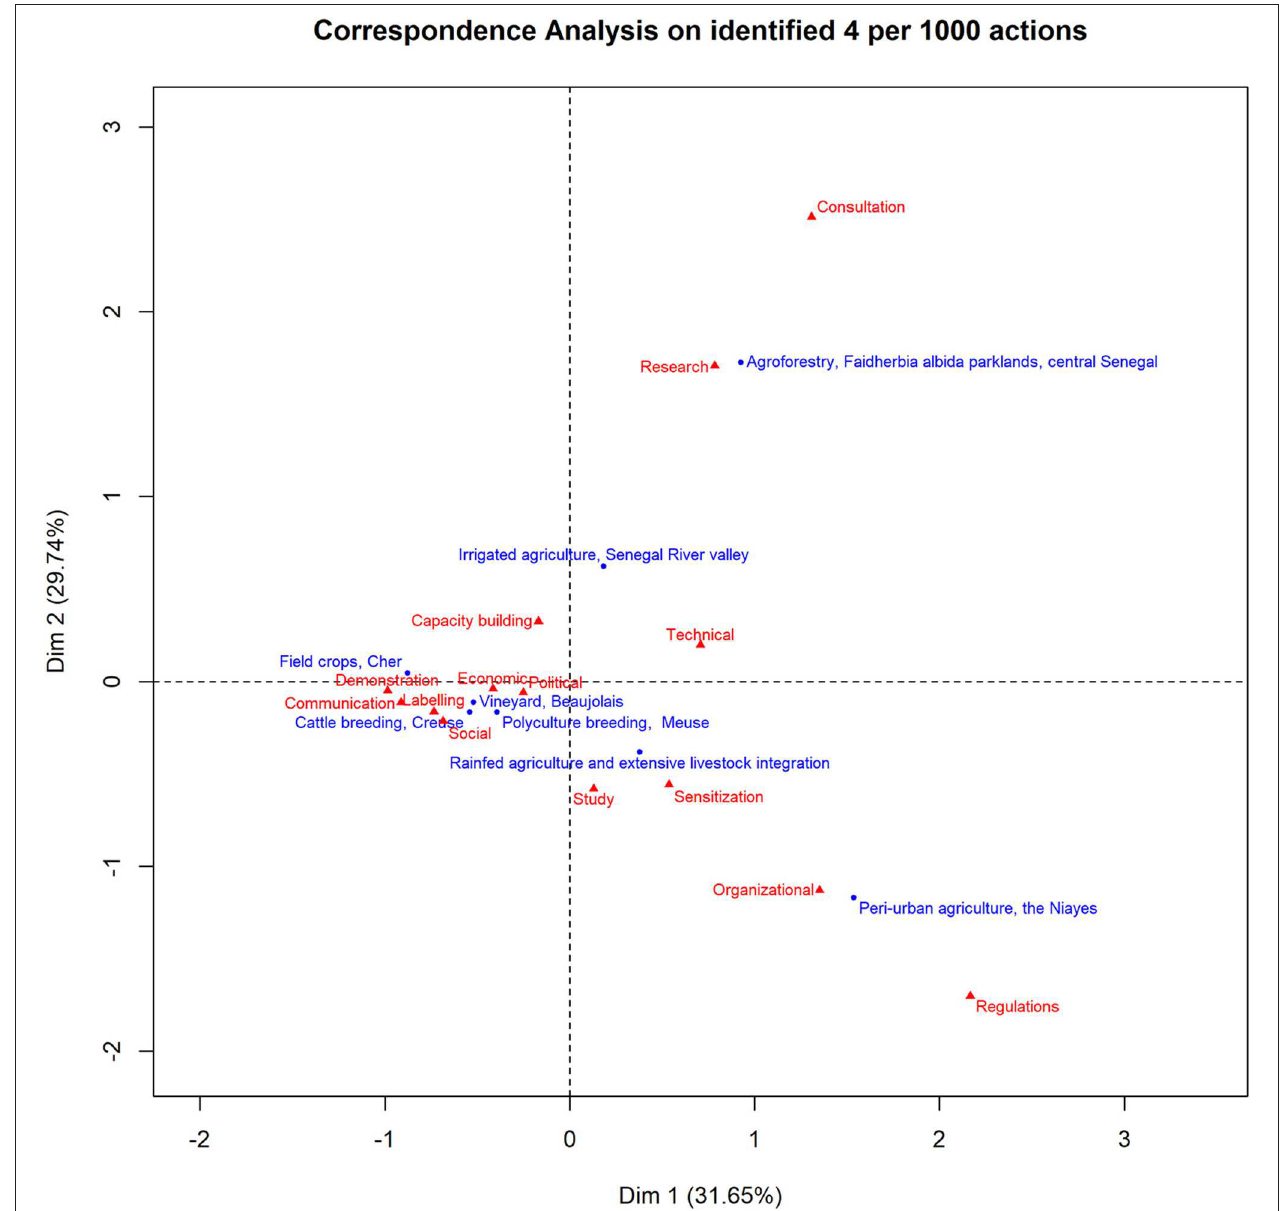
FIGURE 2 | Correspondence Analysis on potential actions proposed by stakeholders to boost soil carbon sequestration in eight different farming systems in France and Senegal. Farming systems are in blue. Category of actions are in